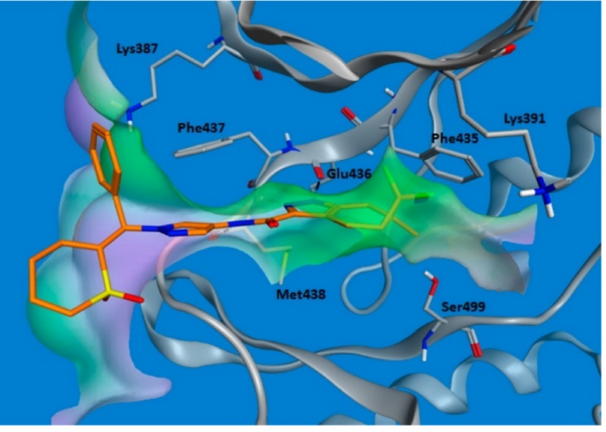
Figure 42. Co-crystal binding interactions of GNE-4997 (compound 39 ) with ITK